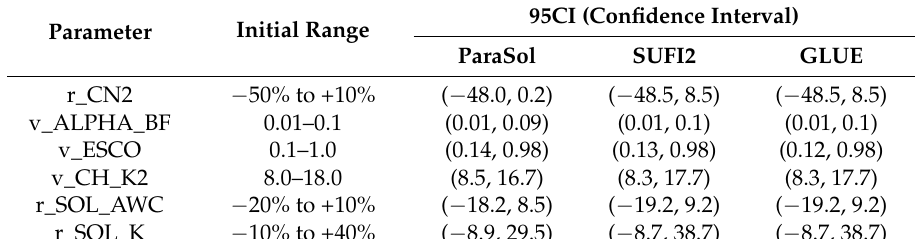
Table 3. Uncertainty ranges of aggregate parameters from the three methods.